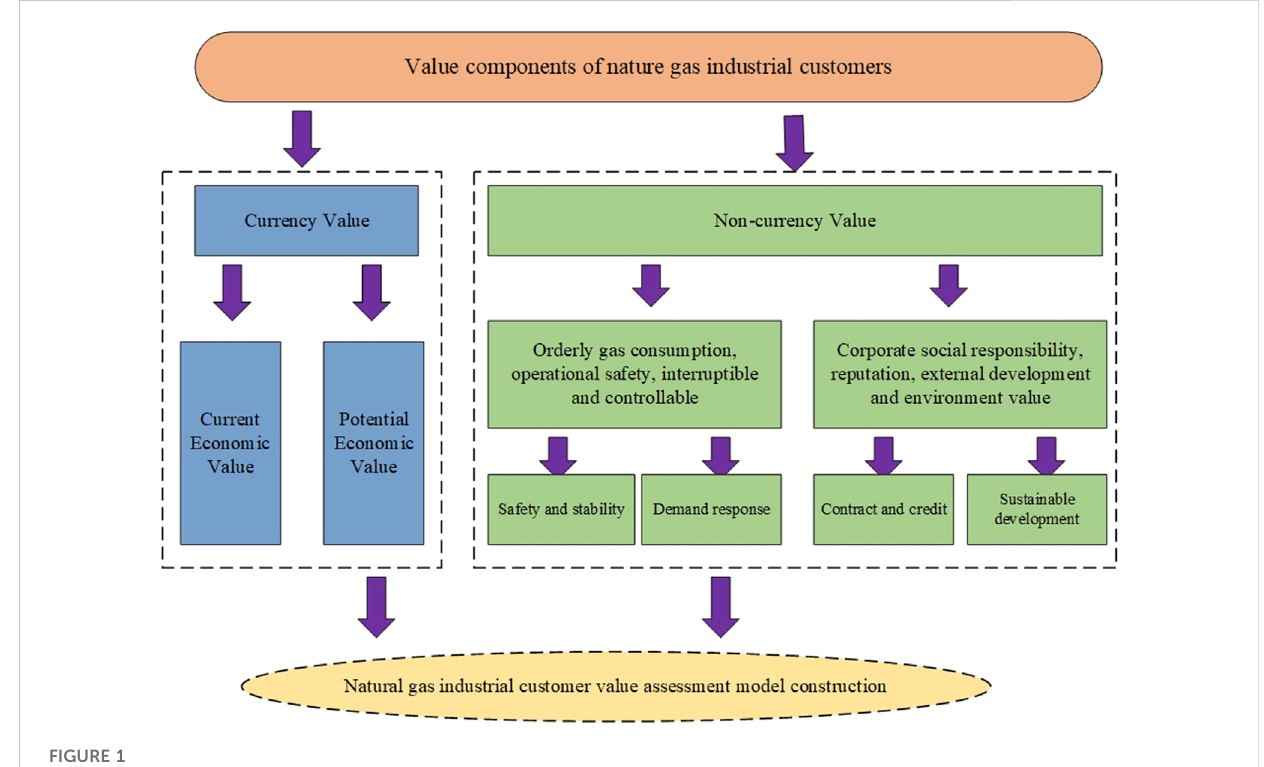
FIGURE 1 Value composition of natural gas industrial customers.